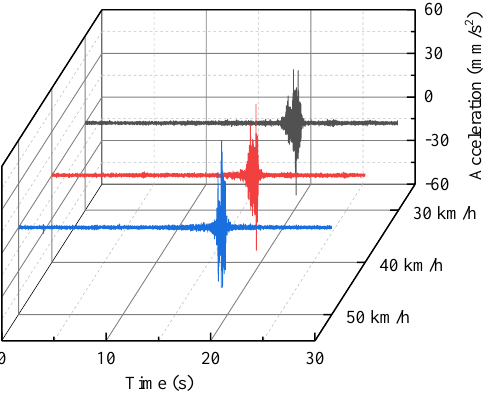
Figure 19. The acceleration of the vibration source replacement point (horizontal east − west direc- tion).